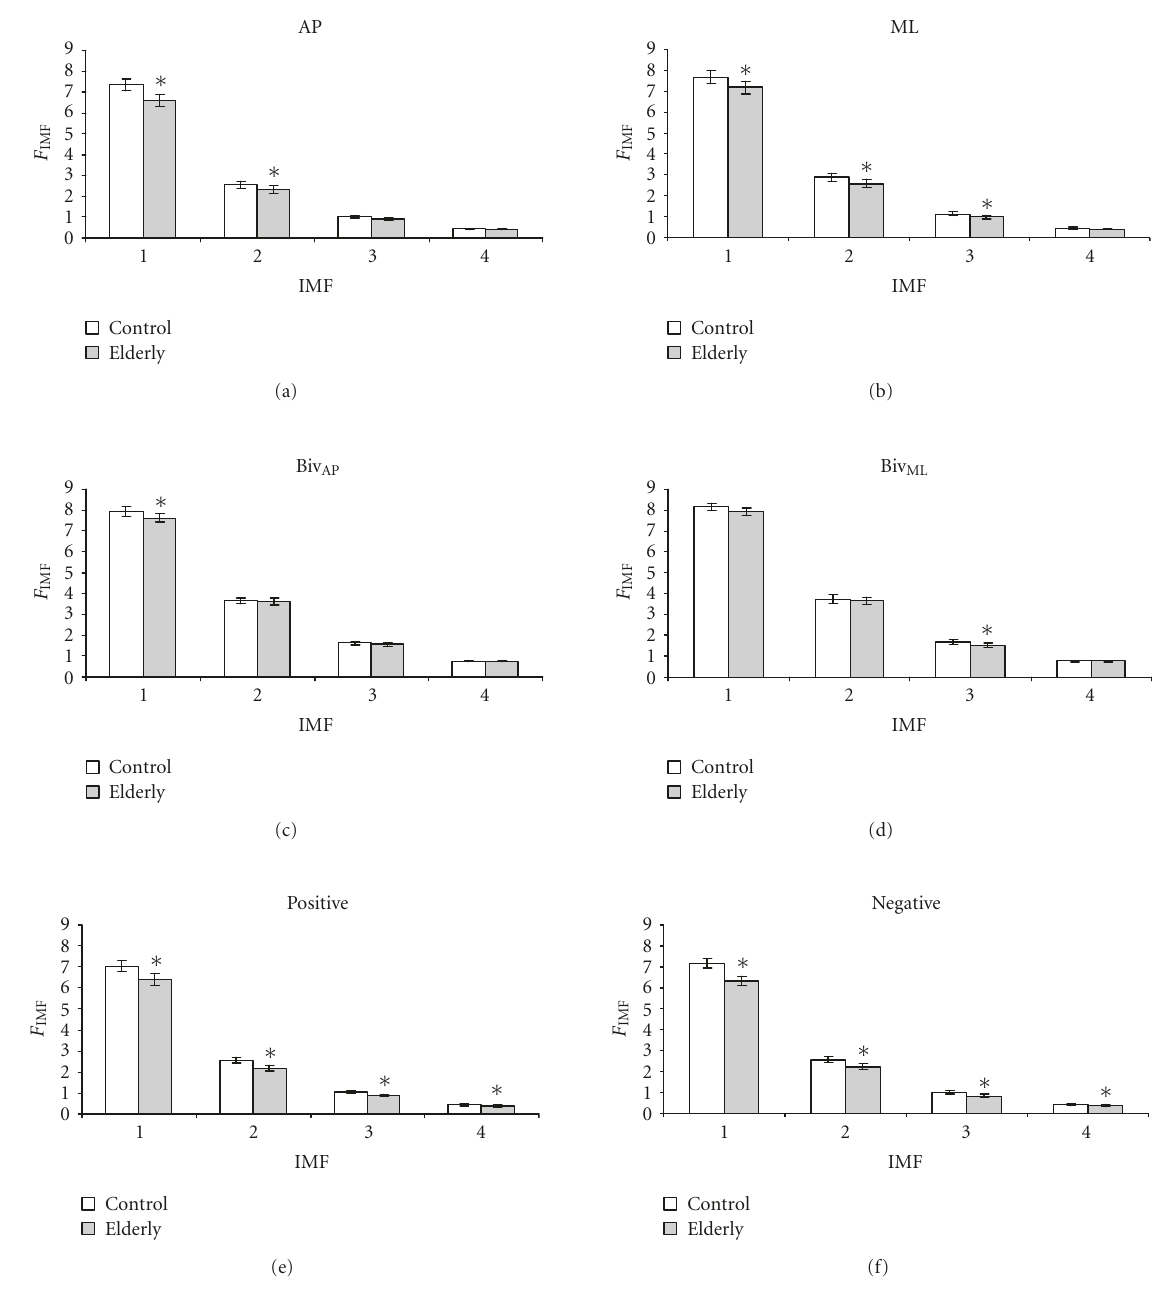
Figure 6: The average rotation frequency ( F IMF ) of the first four IMF for control and elderly subjects. (a) EMD for AP displacement; (b) EMD for ML displacement; (c) bivariate-EMD for the imaginary part of the signal (corresponding to AP displacement); (d) bivariate-EMD for the real part of the signal (ML); (e) complex-EMD for positive components; and (f) complex-EMD for negative components. Data are mean and 95% confidence intervals. ∗ Significant di ff erence from control